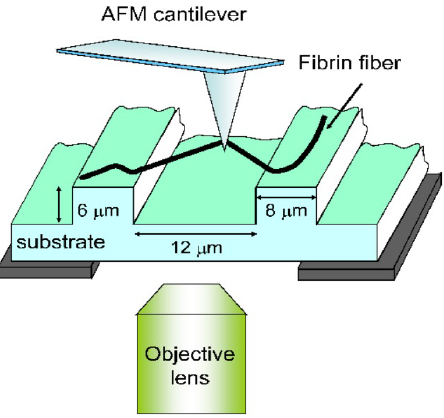
Figure 20. Schematic of AFM/optical microscopic apparatus setup. Reproduced from [142] with the permission of Elsevier.